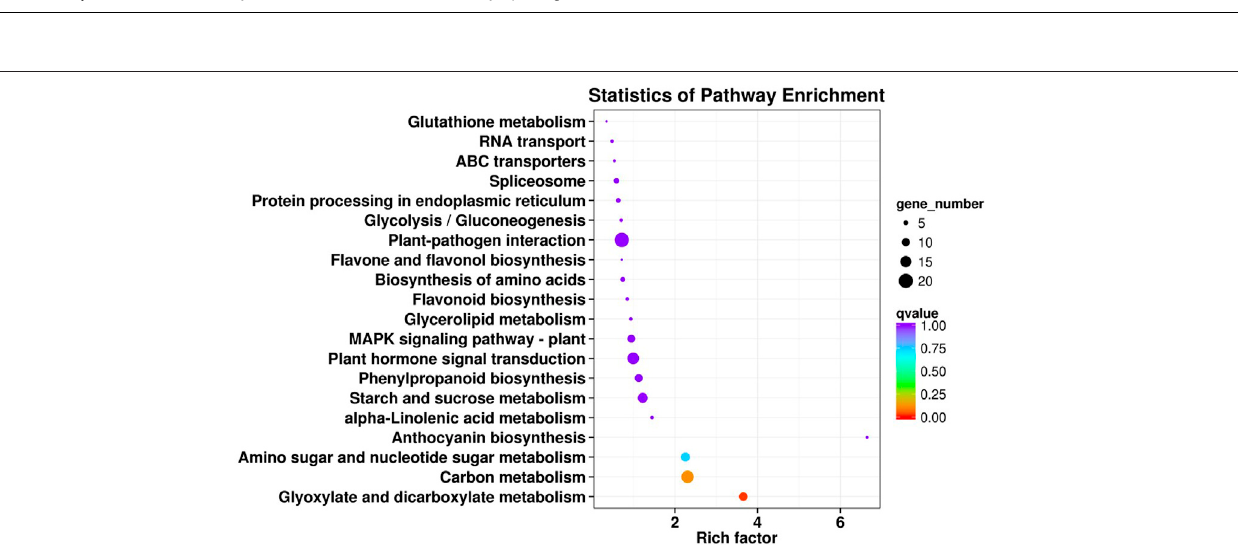
FIGURE 4 | The KEGG enriched scatter plot of common DEGs in the early-ripening mutant LZ. Rich factor refers to the ratio of the DEG number enriched in the pathway to the number of annotated genes. The bigger the Rich factor, the more signi fi cant the enrichment is. The q-value is the corrected p -value after multiple hypotheses testing, and from red to purple indicates the q-value level.